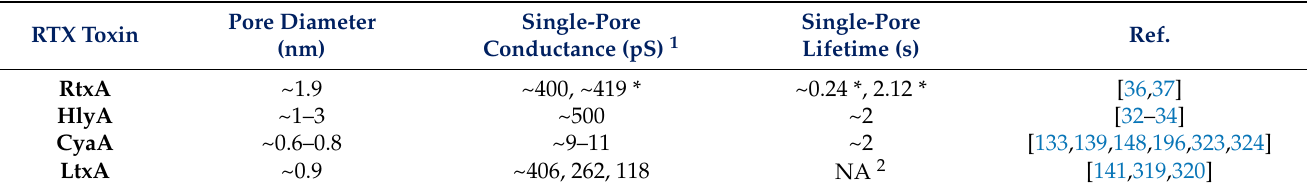
Table 4. Properties of pores formed by RTX